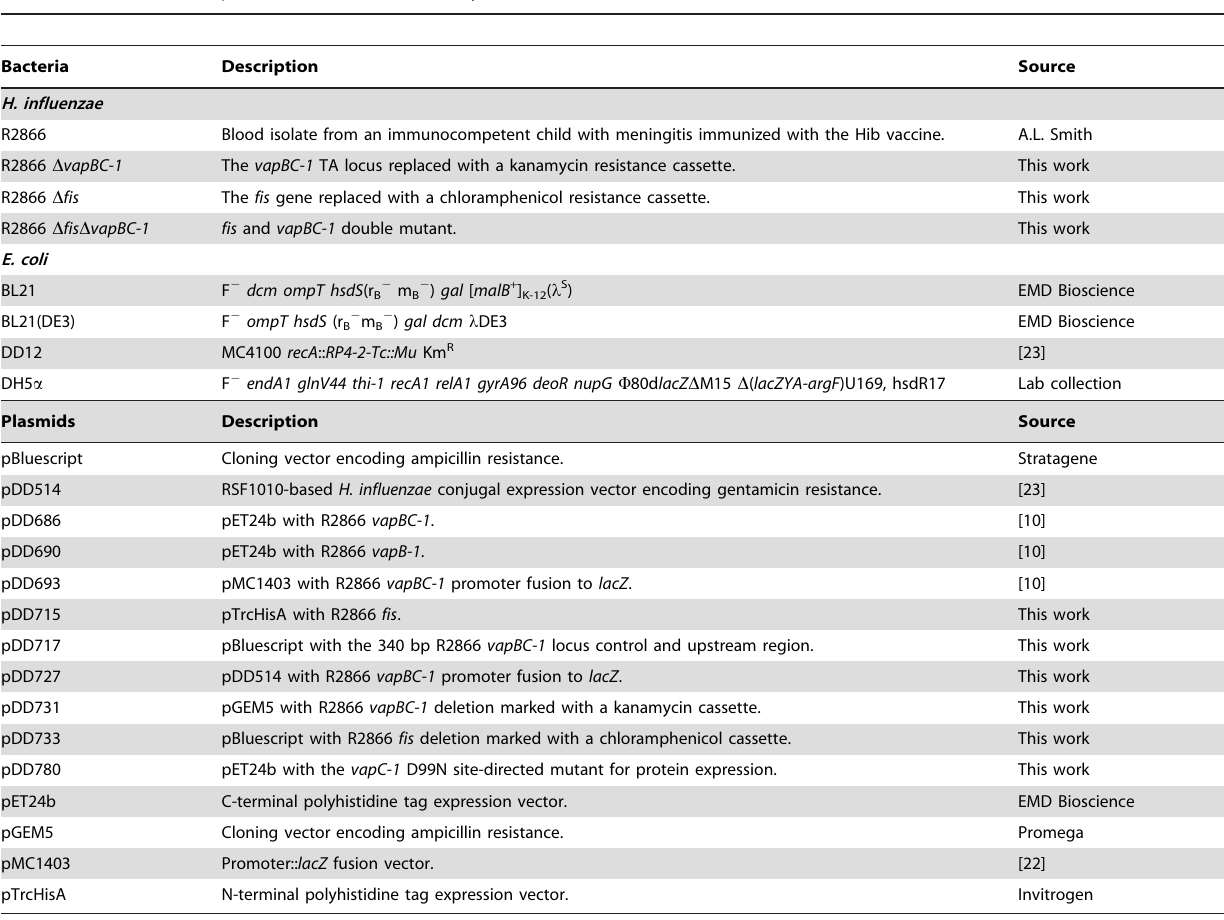
Table 1. Bacteria and plasmids used in this